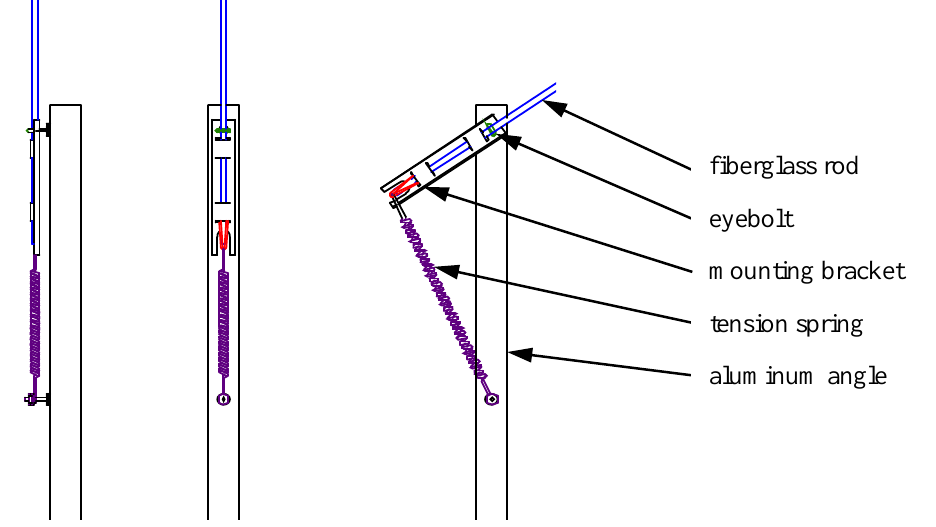
Figure 1. Side ( Left ) and front ( Middle ) views of the radio/antenna mounting system in the normal, unflexed orientation, and flexed, under strain ( Right